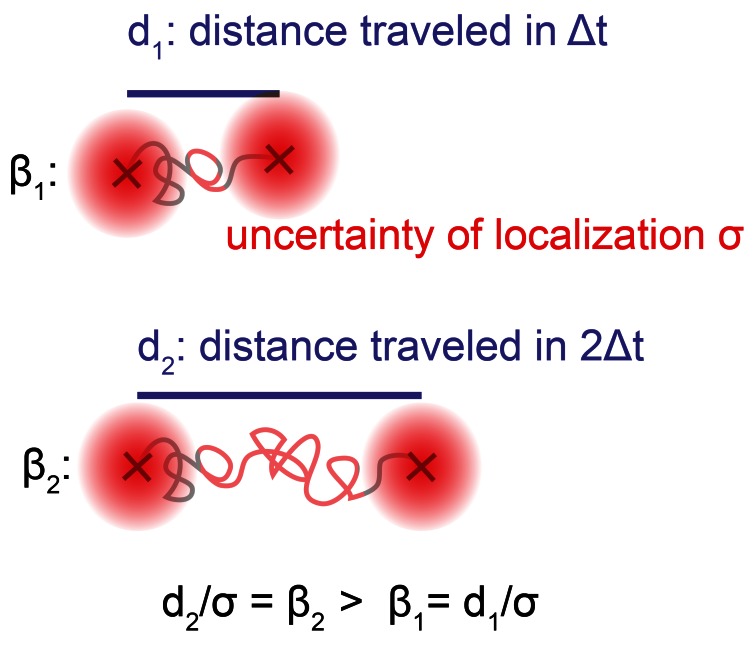
Illustration of the parameter β.Depending on the SNR, a particle can be localized within a certain localization precision σ (red circle). After a certain time interval the particle has traveled a distance d. If σ is a substantial fraction of the distance d (i.e. β is small), the measurement of d is imprecise, leading to errors in the determination of the diffusion coefficient. Increasing the time interval Δt and thus β allows a more precise measurement of d.